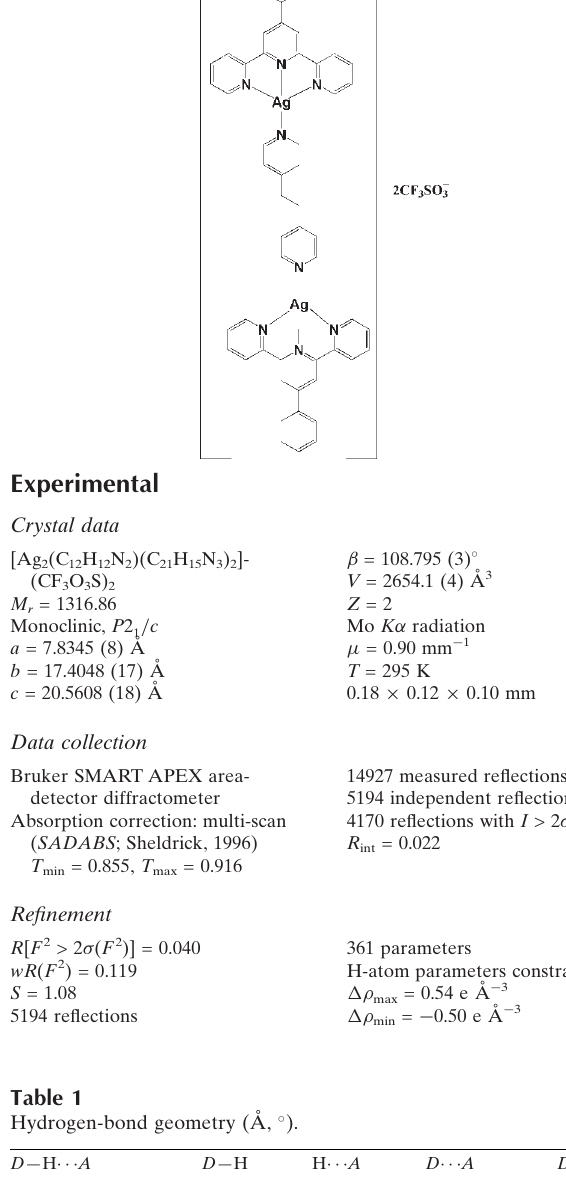
Hydrogen-bond geometry (A˚ , (cid:4)